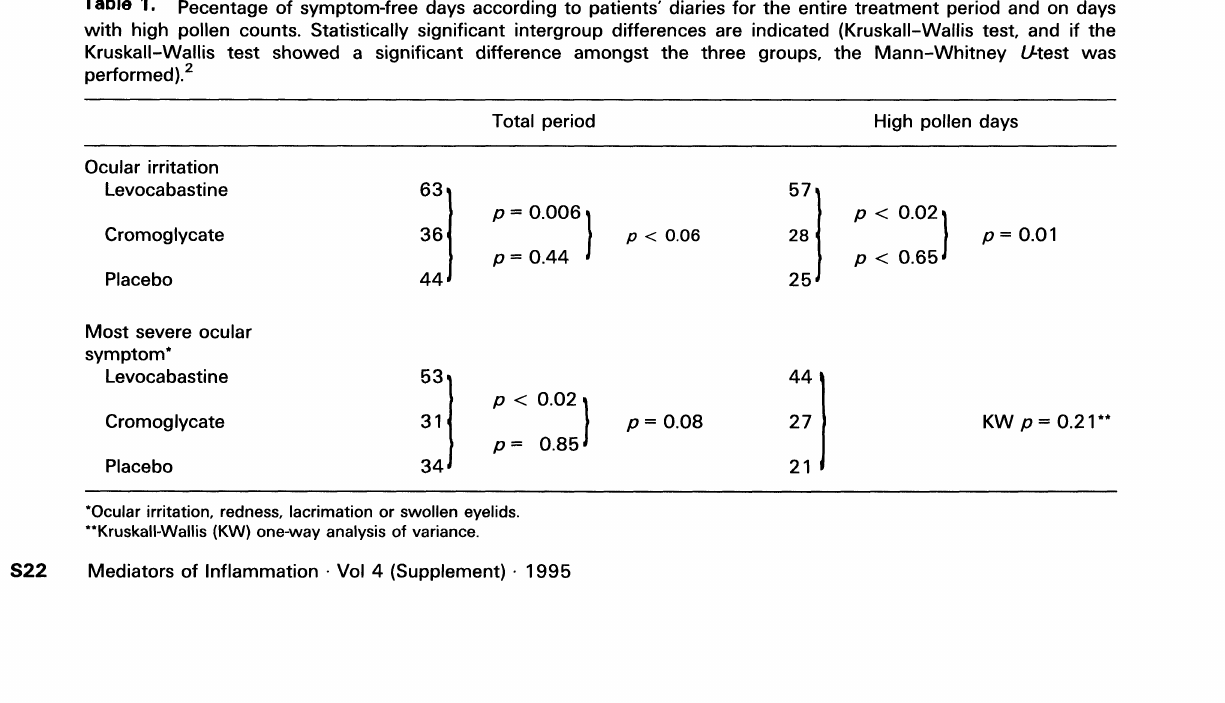
Table 1, Pecentage of symptom-free days according to patients’ diaries for the entire treatment period and on days with high pollen counts. Statistically significant intergroup differences are indicated (KruskalI-Wallis test, and if the KruskalI-Wallis test showed a significant difference amongst the three groups, the Mann-Whitney U-test was performed). 2 Total period High pollen